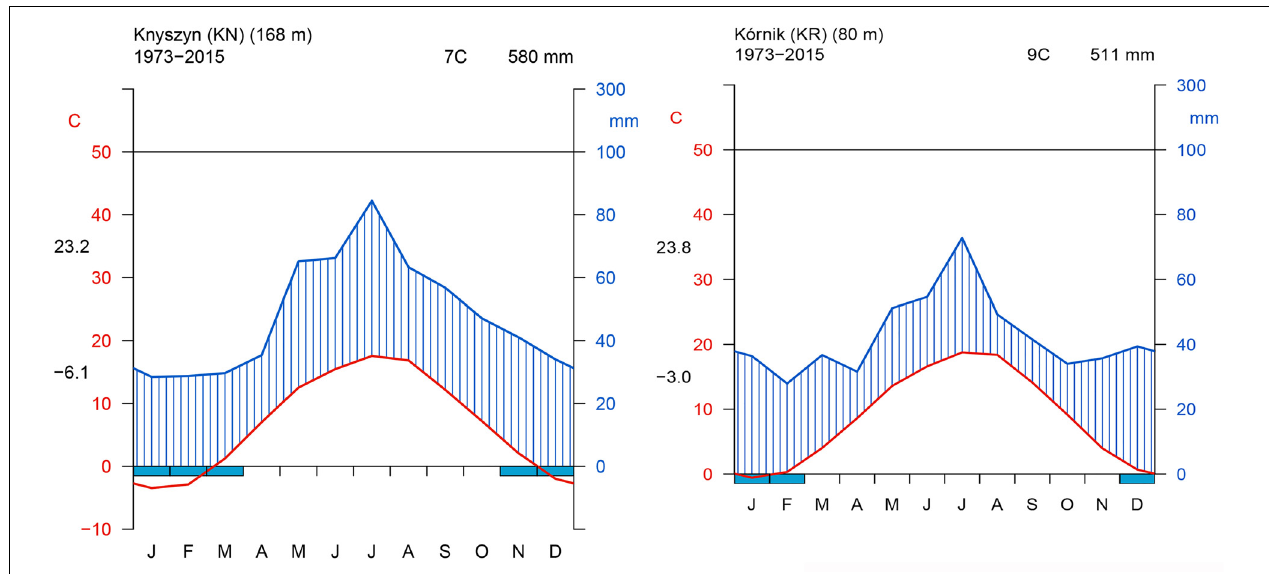
FIGURE 2 | Walter and Lieth climatic diagram of study sites. Left panel – Knyszyn site, Right panel – Kórnik site.